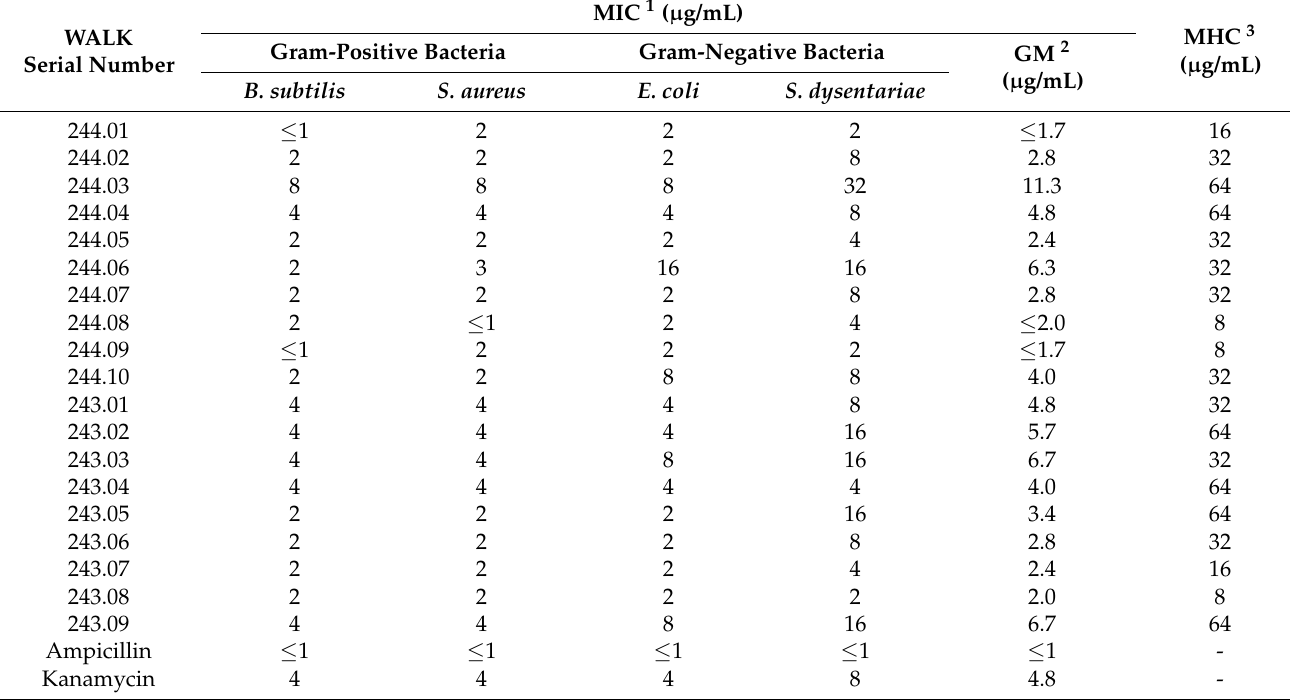
Table 1. Antibacterial and hemolytic activities of WALK244 and WALK243 peptide